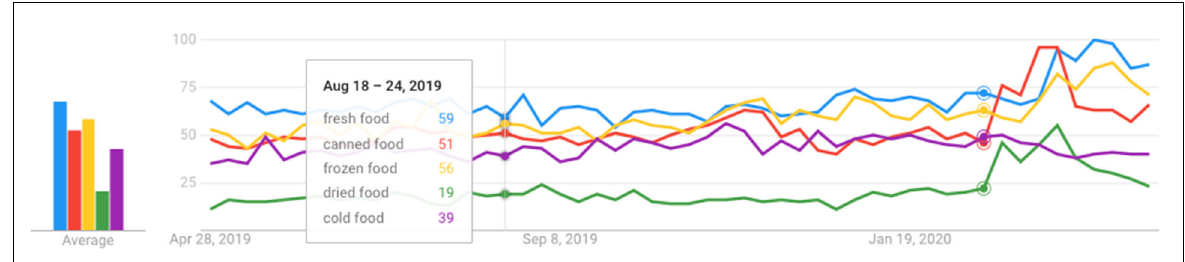
Figure 1. Interest Over Time: Food by Storage-Related Processing (last 12 months)